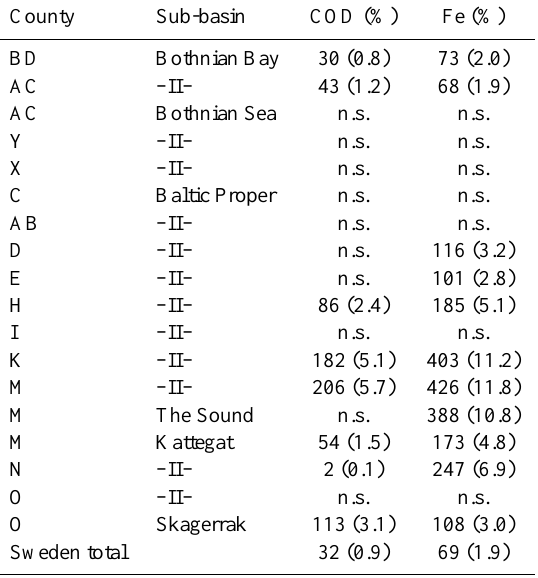
Table 2. Percent change in discharge of total organic matter, mea- sured as COD, and Fe in river mouths of the respective counties (shown in Fig. 1) into the different sub-basins between 1972 and 2008. Numbers within brackets show the yearly rate of change in